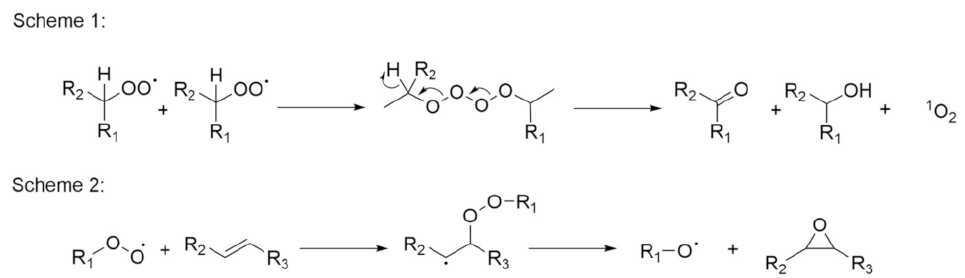
Figure 4. The termination reaction (Scheme 1) and epoxide formation (Scheme